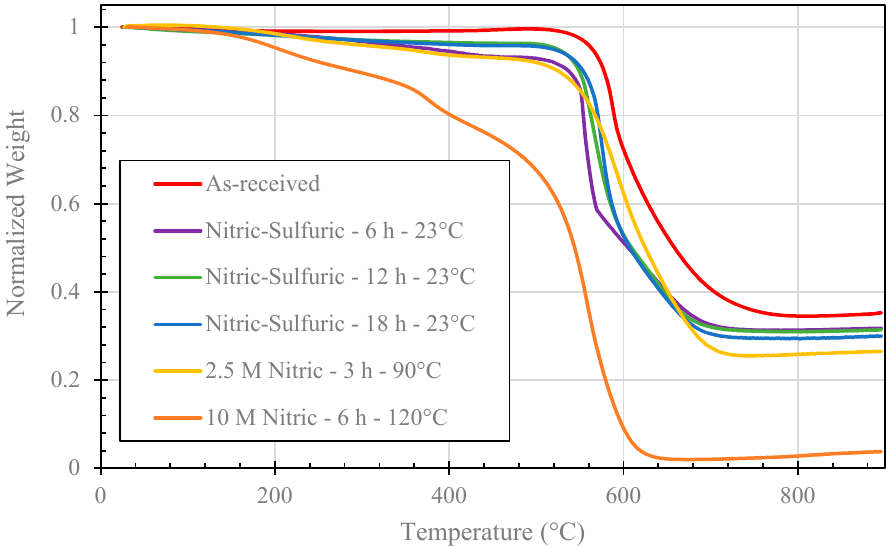
Figure 6. Normalized mass loss TGA results of CNT samples: as-received, treated with nitric/sulfuric acid mixture at 23 °C (6, 12, and 18 h), 2.5 M nitric acid at 90 °C for 3 h, and 10 M nitric acid at 120 °C for 6 h.